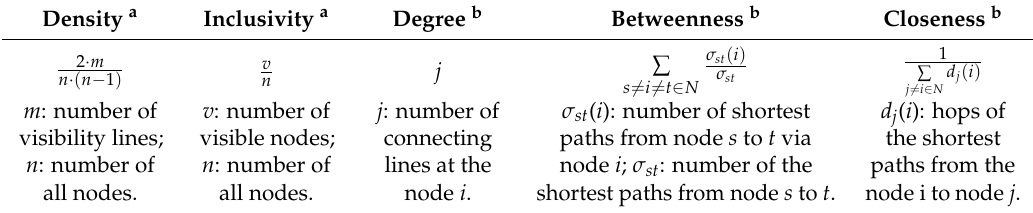
Table 2. The complex network analysis (CNA) measures in the visibility network [35–37]. Density